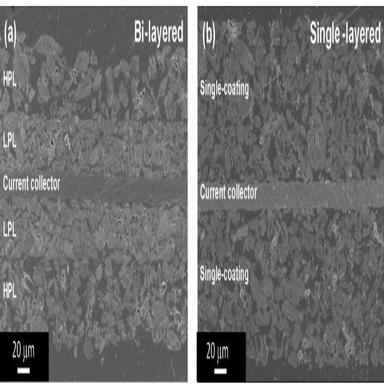
FE-SEM images at X1000 magnification of the cross section of the (a) bi-layered and (b) single-layered coating.